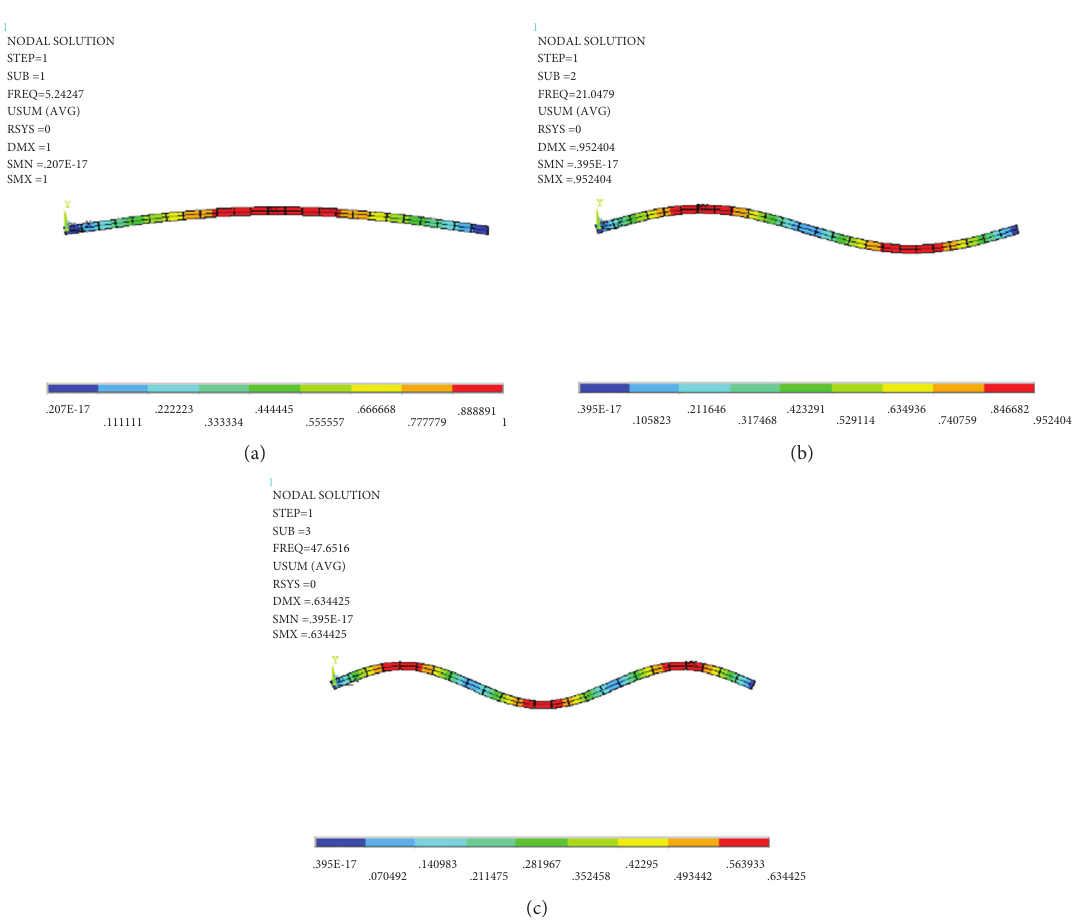
Figure 8: Modal shape cloud diagram of nondamage case. (a) 1 st order mode. (b) 2 nd order mode. (c) 3 rd order mode. Table 3: Prior probabilities of elements. Element